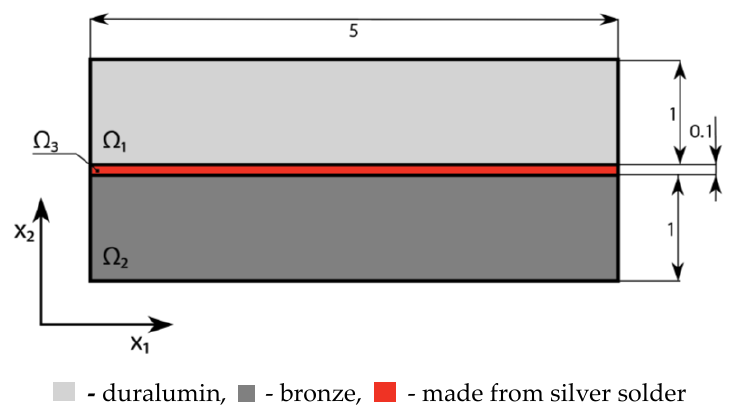
Figure 2. Design of a symmetric three-layer package (Unit: mm).